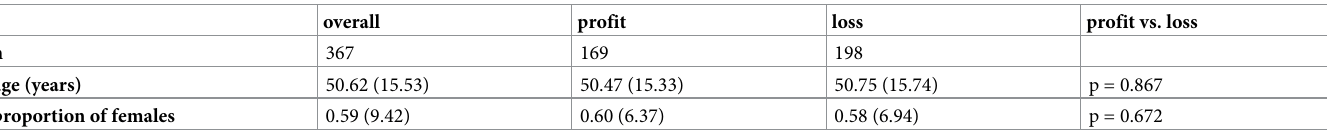
Table 1. Age and gender by outcome in Study